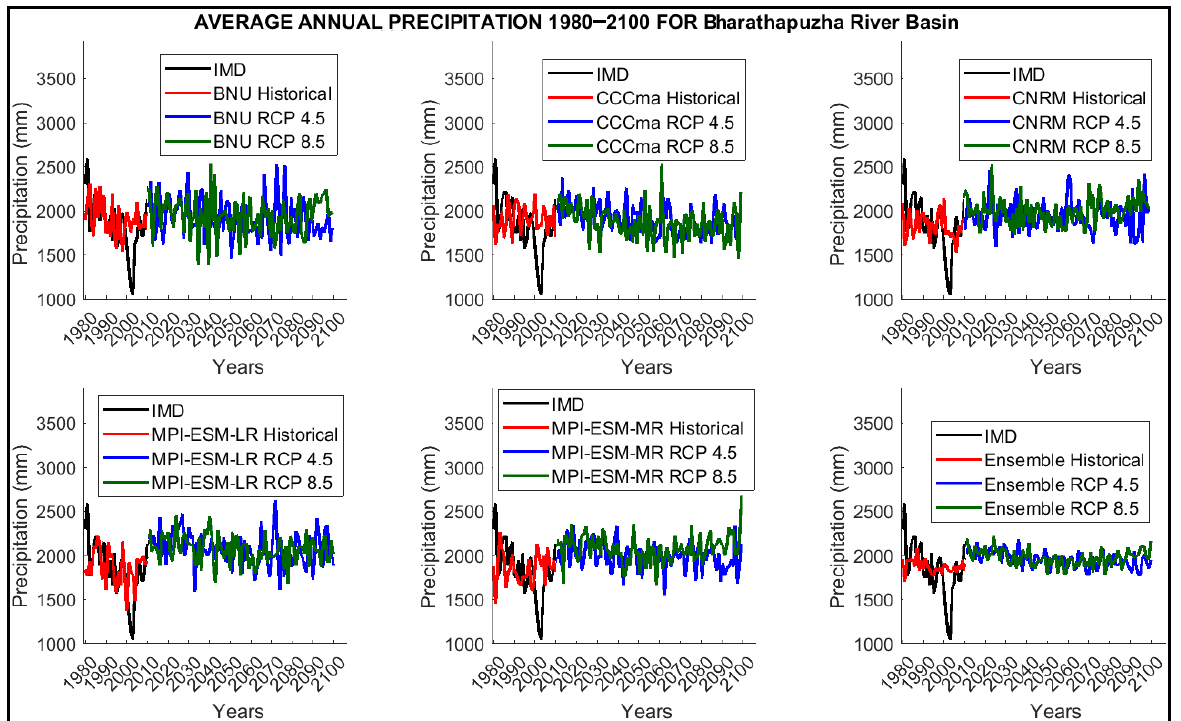
Figure 5. Comparison of observed and GCMs simulated rainfall during historical (1981 to 2010) and future periods (2011 to 2100).